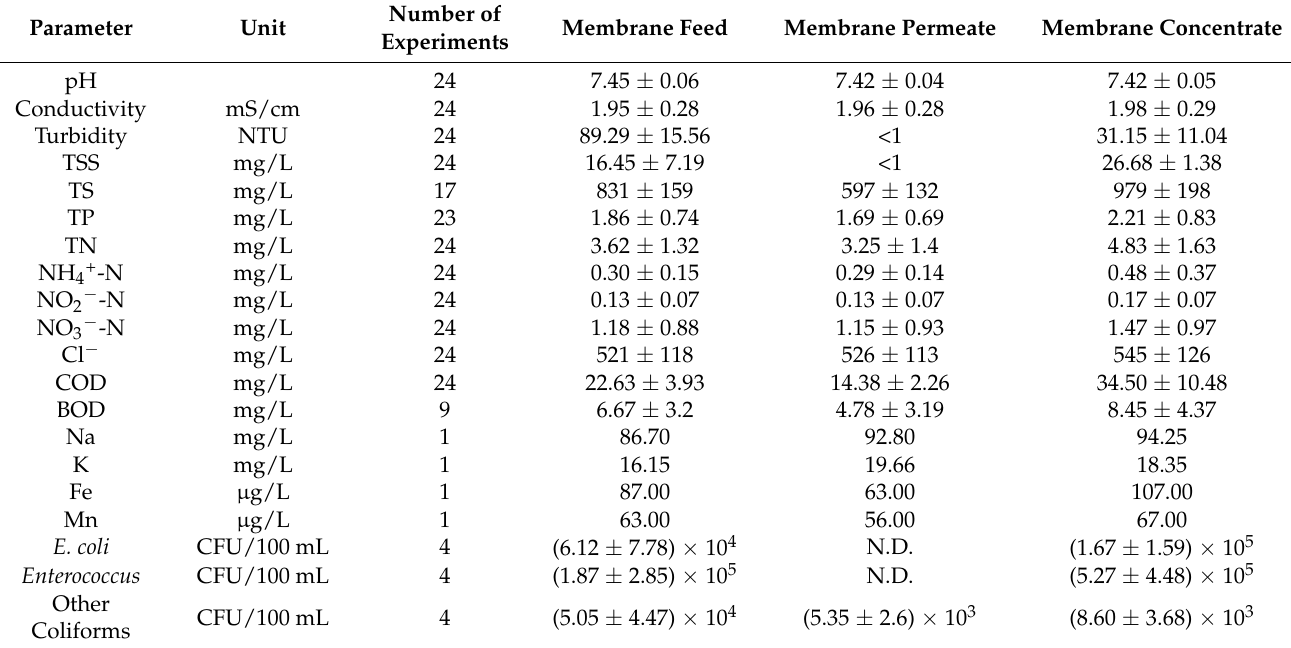
Table 3. Average physicochemical characteristics of feed, permeate, and concentrate streams during the timespan of membrane